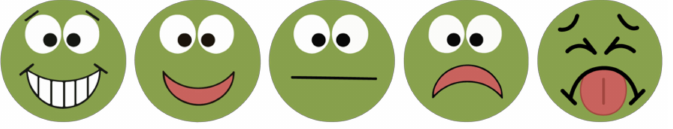
Figure 5. Non-gendered 5-point face scale “super yummy/super